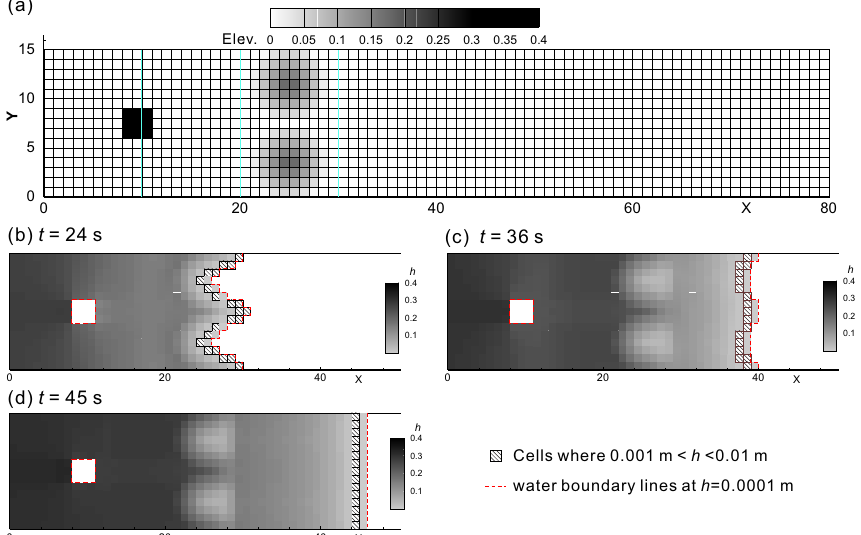
Figure 6. Test case of a flood routing over three mounds. (a) Bed elevation and computational grids; (b) flood extent and water depth contour at t = 24s; (c) flood extent and water depth contour at t = 36s; (d) flood extent and water depth contour at t = 45s.